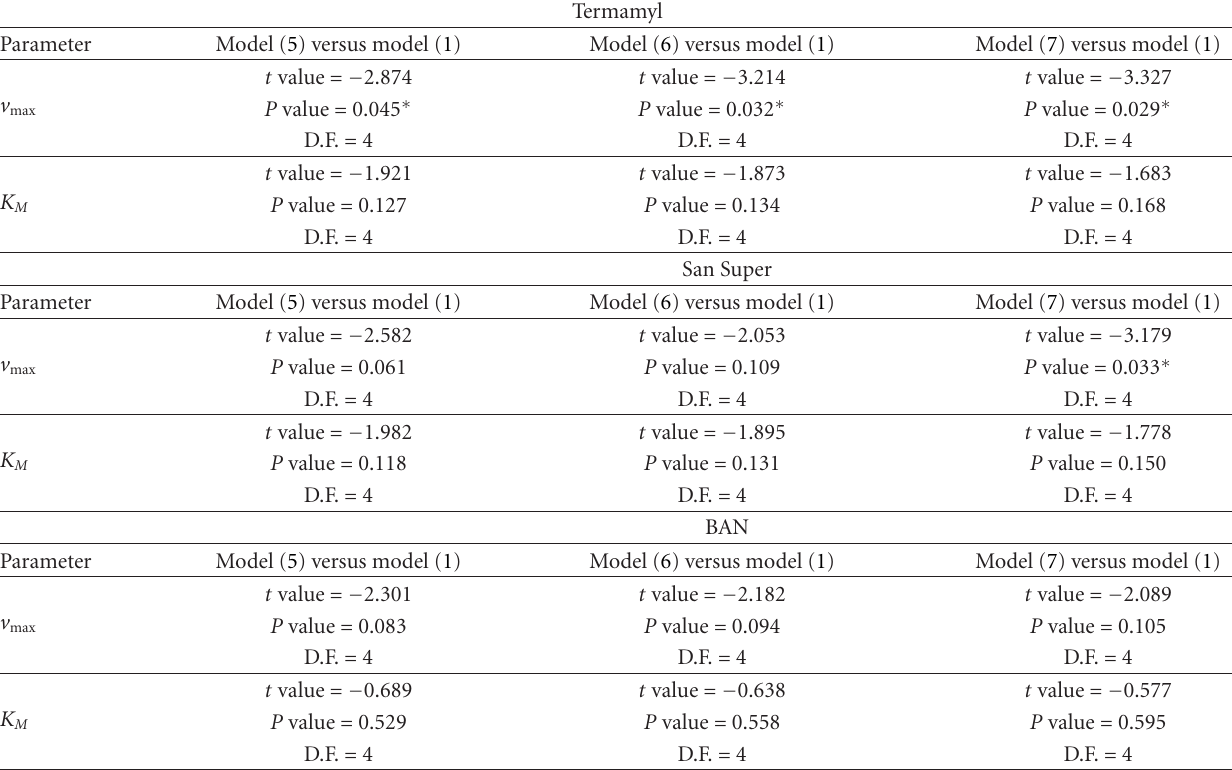
Table 6: Comparison between the values of v max and K M obtained with the overall models (5), (6), and (7) (Table 5) and those obtained with the classical Michaelis-Menten model (1) for the enzymatic reactions of the three amylolytic enzymes in unaged starch without gelatine (Table 4). ∗ Significant di ff erences for P < 0 . 05. D.F.: Degrees of